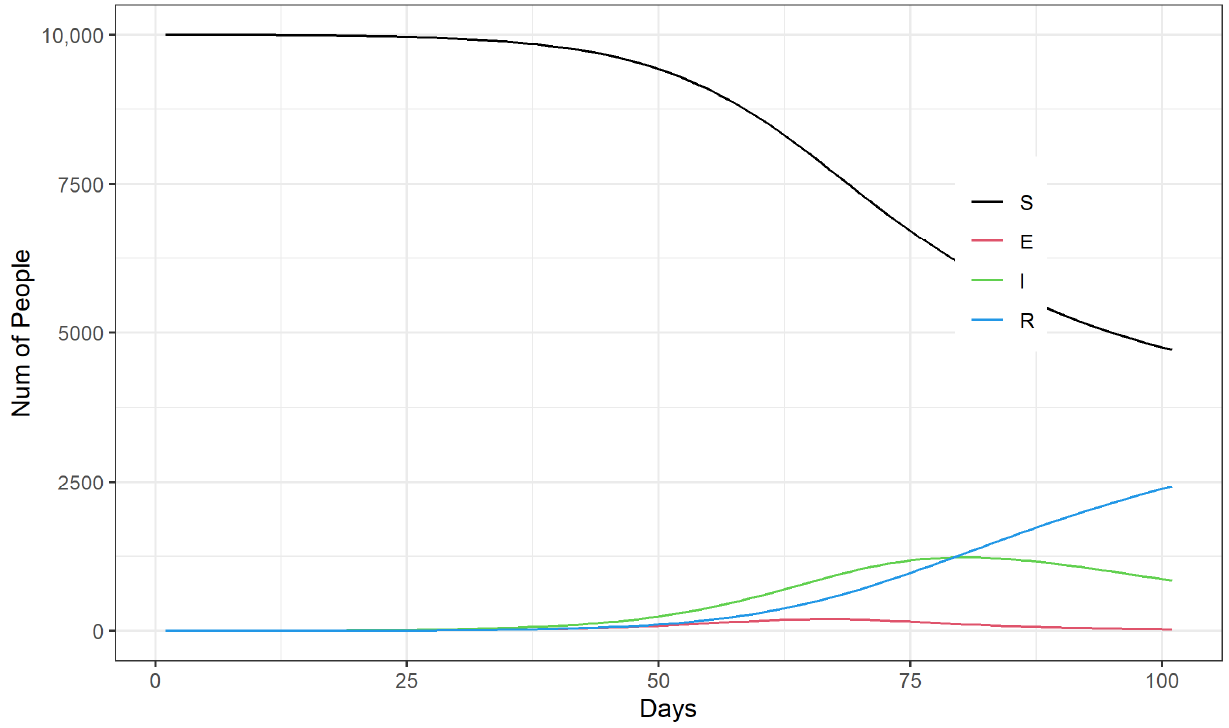
Figure A5. The influence of the daily testing capacity of 2000 person on the evolutionary process of the epidemic; (The unit of the ordinate is “person”).